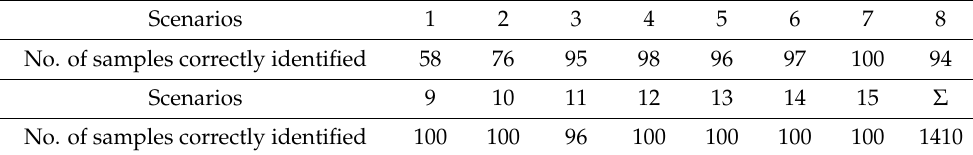
Table 4. Test results of CNN-LSTM on damage localization of the hangers.